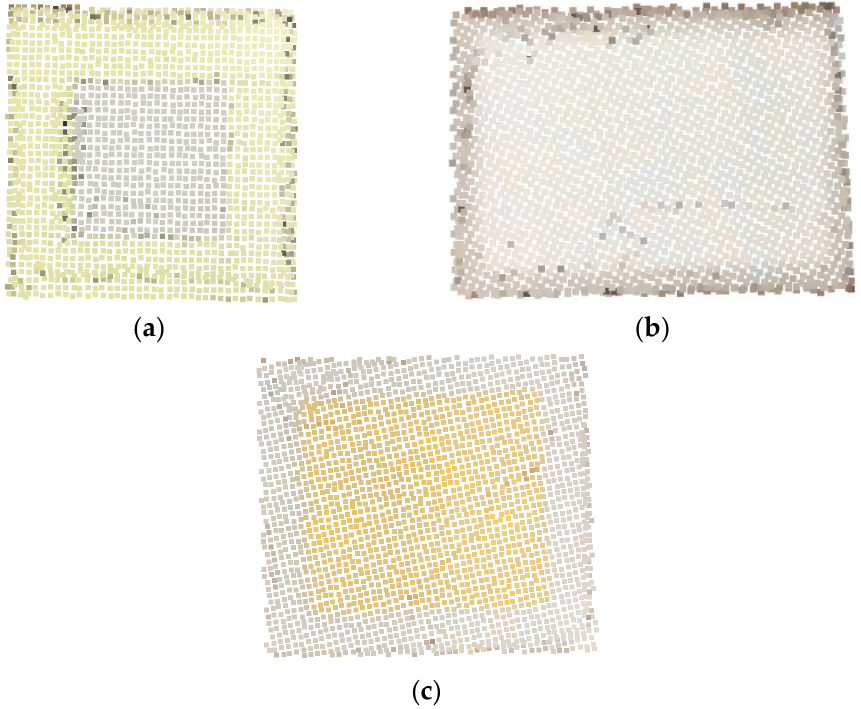
Figure A1. Examples of point clouds: raw cement plaster ( a ), white lime plaster ( b ), coloured lime plaster ( c ).